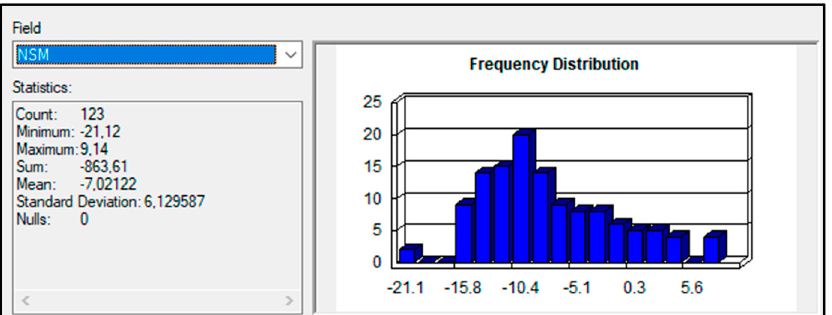
Figure 10. Statistical NSM rates for the 1987–2018 period between Kaminia and Roitika